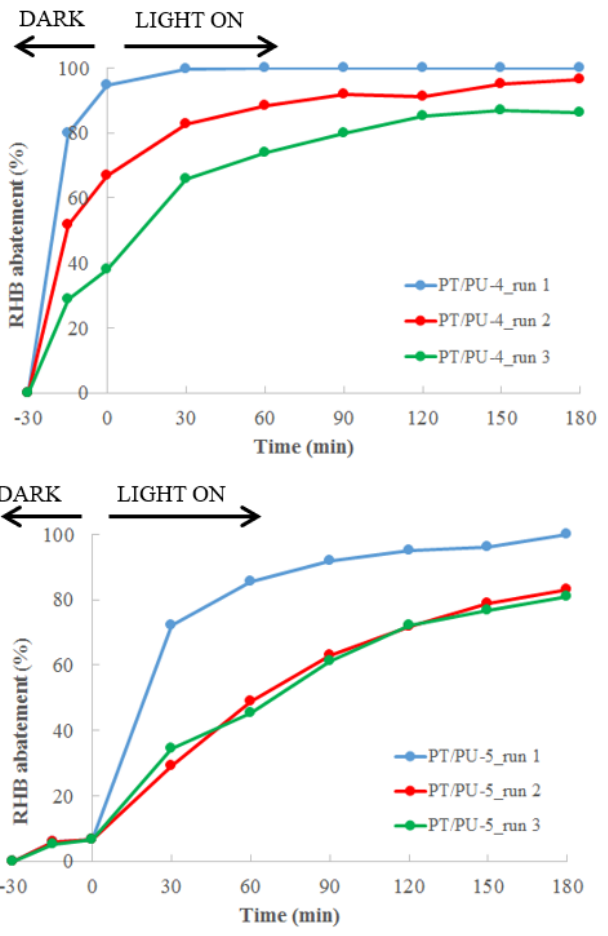
Figure 6. Reuse of PT/PU-4 ( up ) and -5 ( down ) for RHB abatement after washing with UP water. DBSA-doped material (PT/PU-4) shows a gradual decrease of their adsorbent capa- bility within the three performed tests, passing from the ca. 100% of RHB adsorption of the first test to the ca. 86% of the third run, because of the partial saturation of the poly- meric component, where irradiation might not play a significant